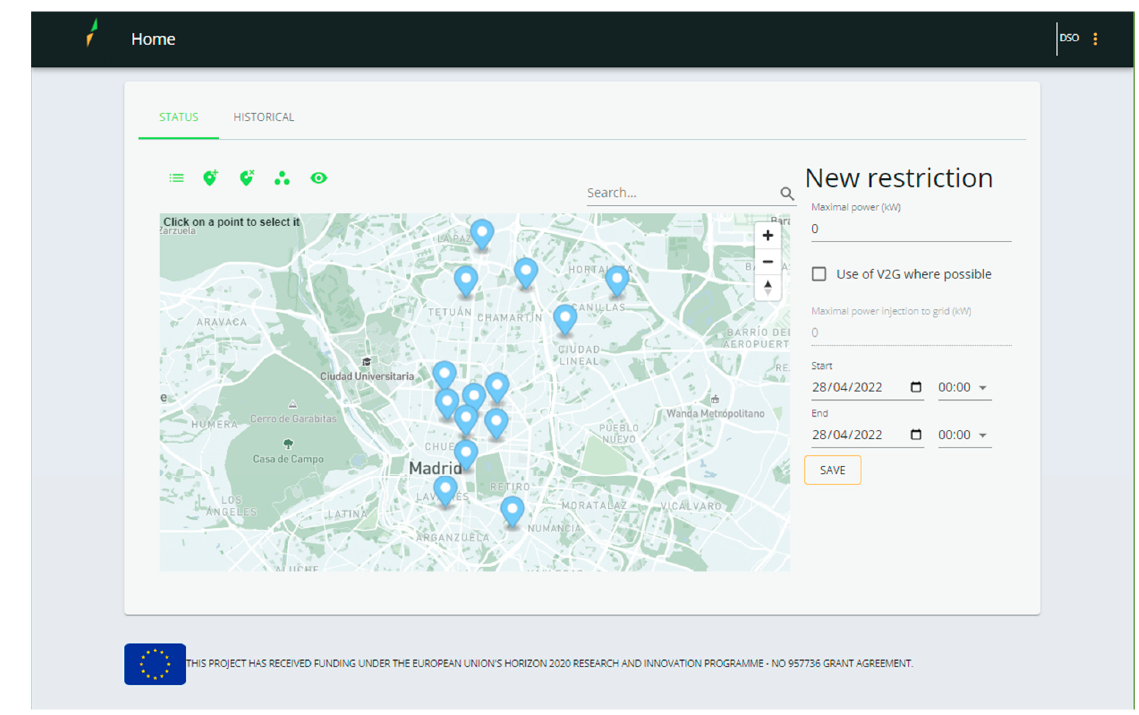
Figure 5. Main screen of “TwinEV for Grid Operators”. Charge points are represented as blue pins in map. The right form allows inserting restrictions to selected points in the map.